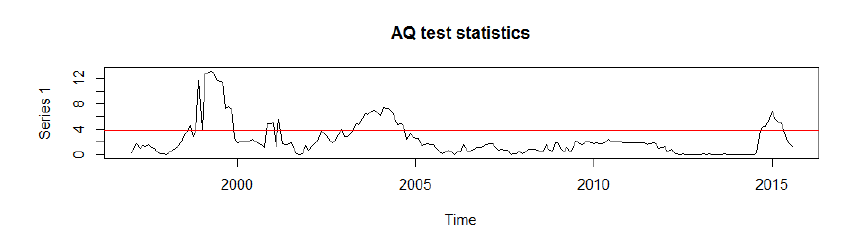
Figure 3. Evolution of Automatic Portmanteau (AQ) statistic with a 3-year rolling window